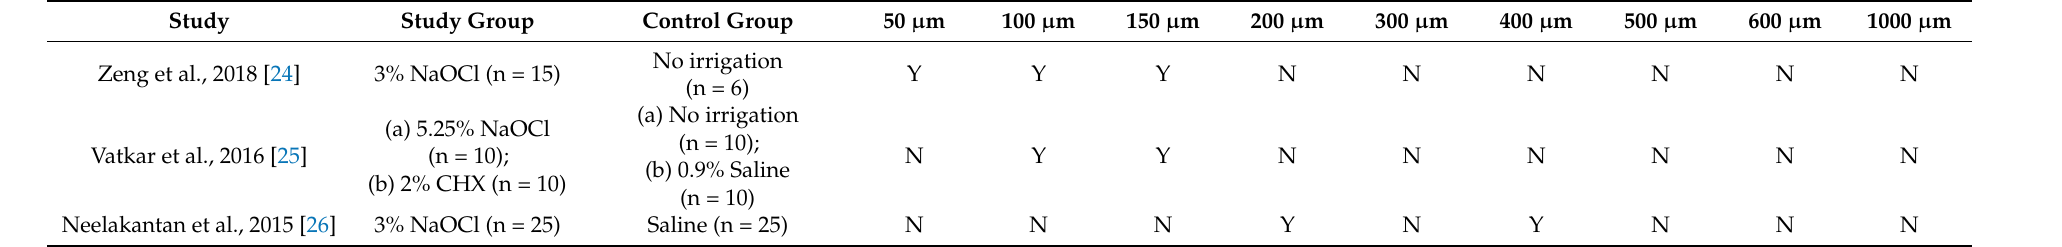
Table 3. Summary of CLSM